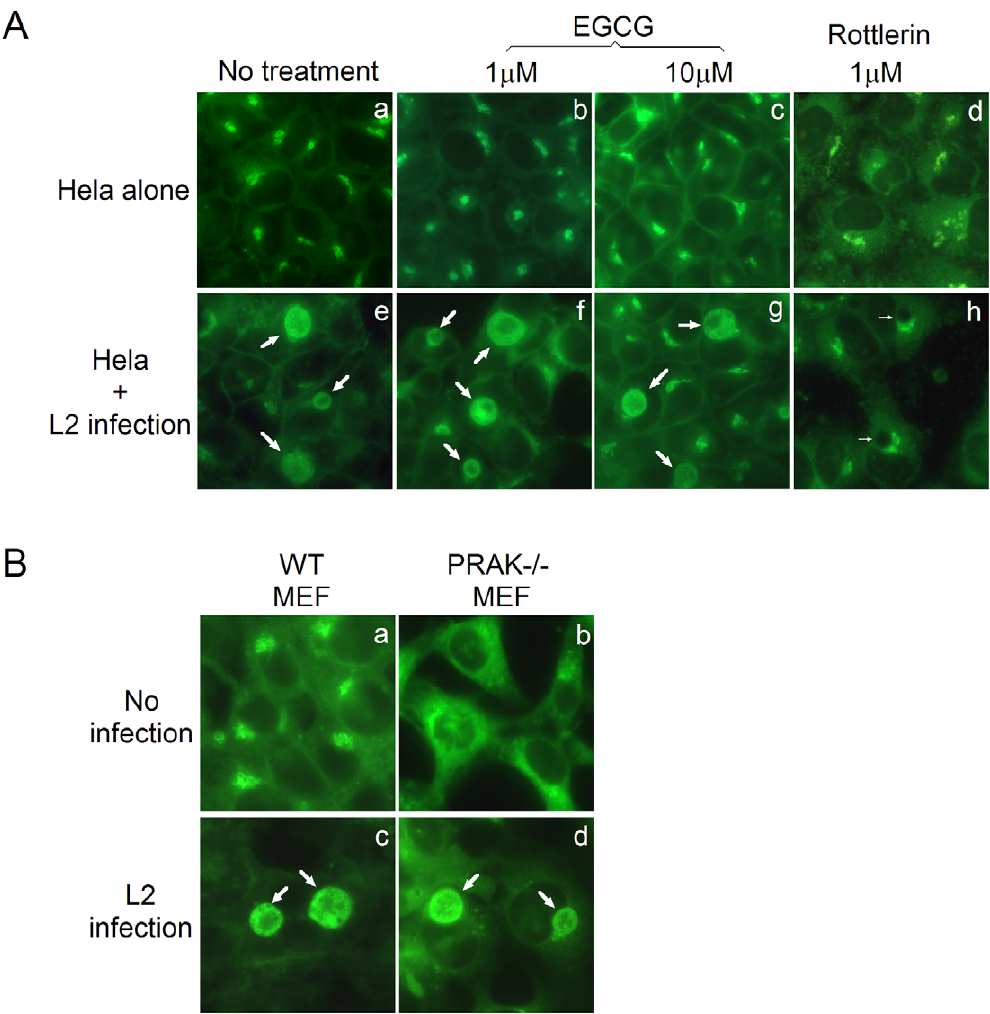
Figure 5. Chlamydiatrachomatis acquisition of host sphingomyelin is independent of PRAK. (A) HeLa cells with (panels e–h) or without (a– d) C. trachomatis infection (MOI=0.5) were treated without (a & e) or with EGCG (1 m M, b & f; 10 m M, c & g) or rottlerin (1 m M, d & h) 16 h post infection. Eight hours later, the cultures were subjected to BODIPY-FL-C5-ceremide labeling and visualized under a fluorescence microscope. Note that EGCG failed to block the accumulation of BODIPY-FL-sphingomyelin in the chlamydial inclusions (panel f & g) while rottlerin did (h). (B) MEF without (panels a & c) or with (b & d) PRAK deficiency (PRAK 2 / 2 ) were infected with C. trachomatis (MOI=0.5) and 24 h post infection, the cultures were labeled with BODIPY-FL-C5-ceremide and observed as described above. Note that C. trachomatis organisms can take up BODIPY-FL- sphingomyelin from MEF cells with or without PRAK. The thick arrows point to chlamydial inclusions with while thin arrows point to the inclusions without the fluorescent